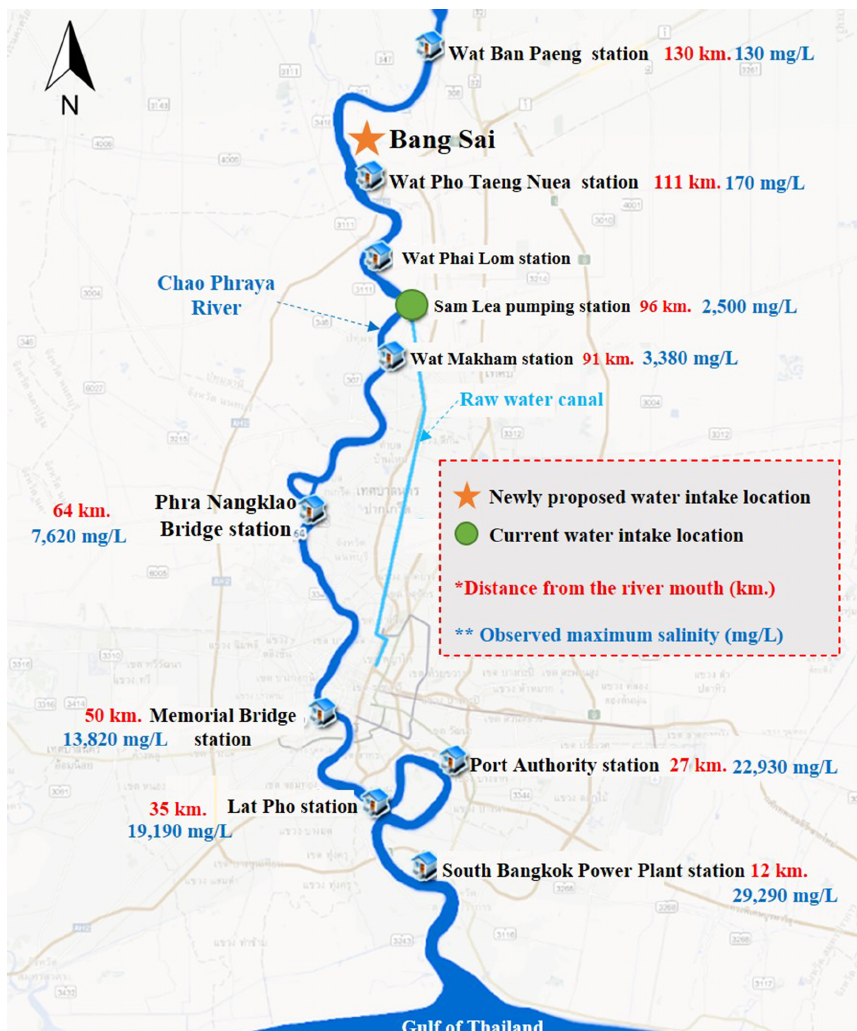
Fig. 7. Option 1: relocation of the current water intake station to the new location in Bang Sai